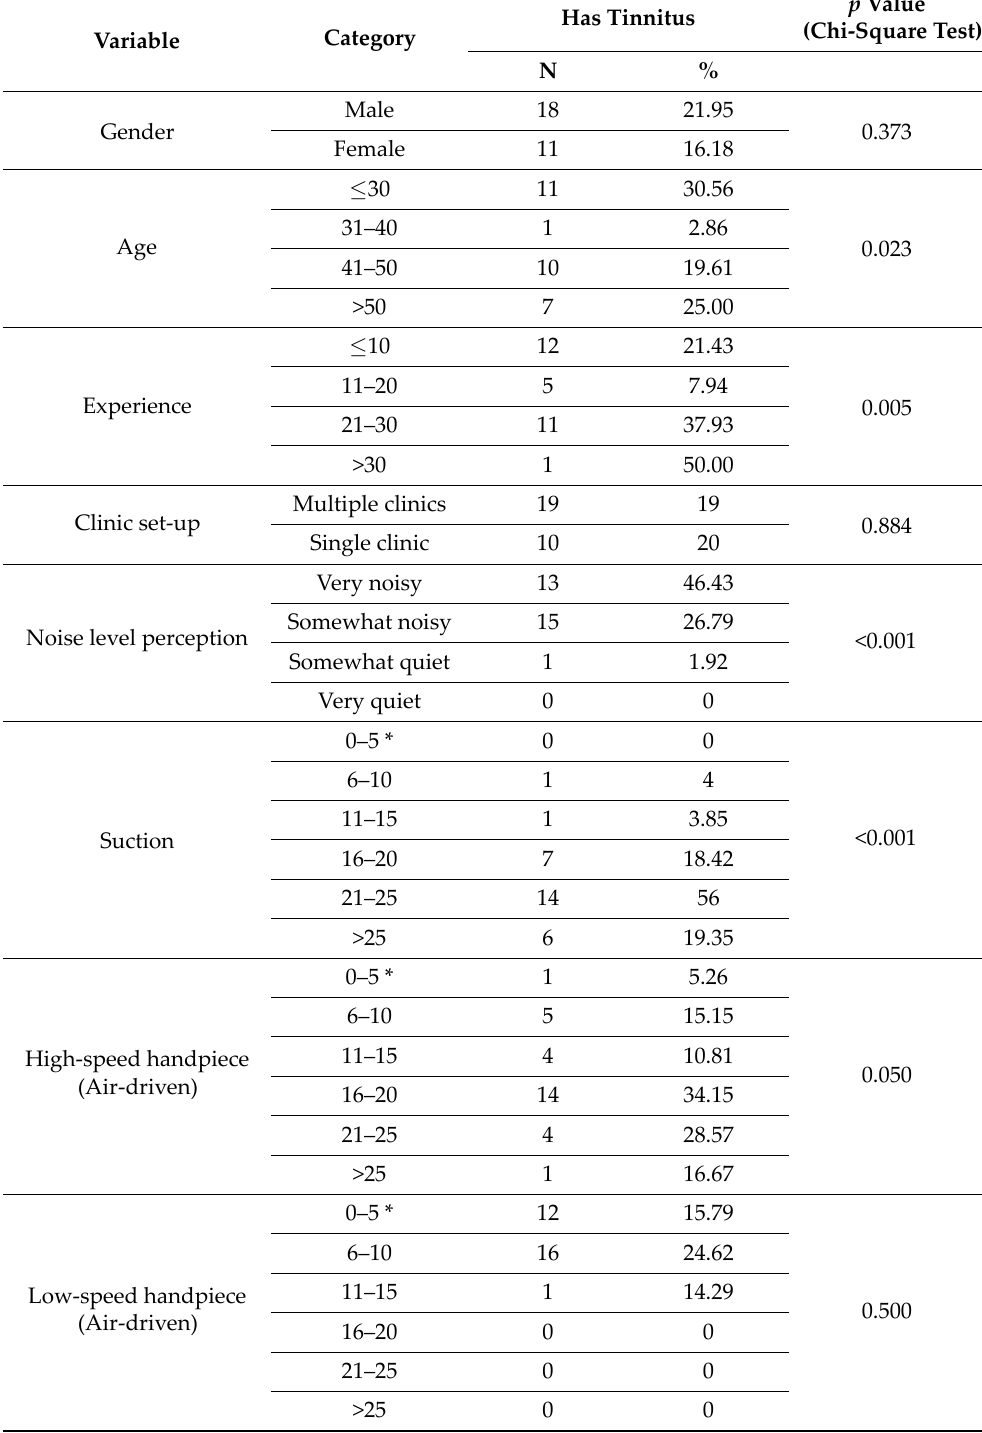
Table 2. Factors associated with tinnitus (* use in hours per